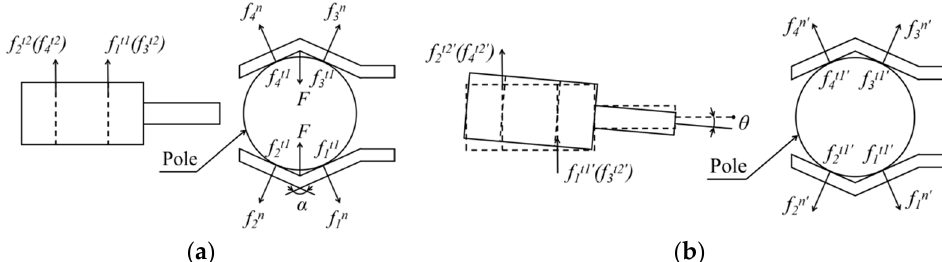
Figure 17. Stress analysis of gripper. ( a ) The contact position of the clamping stage, ( b ) the contact position of during loading. Adapted from [6].